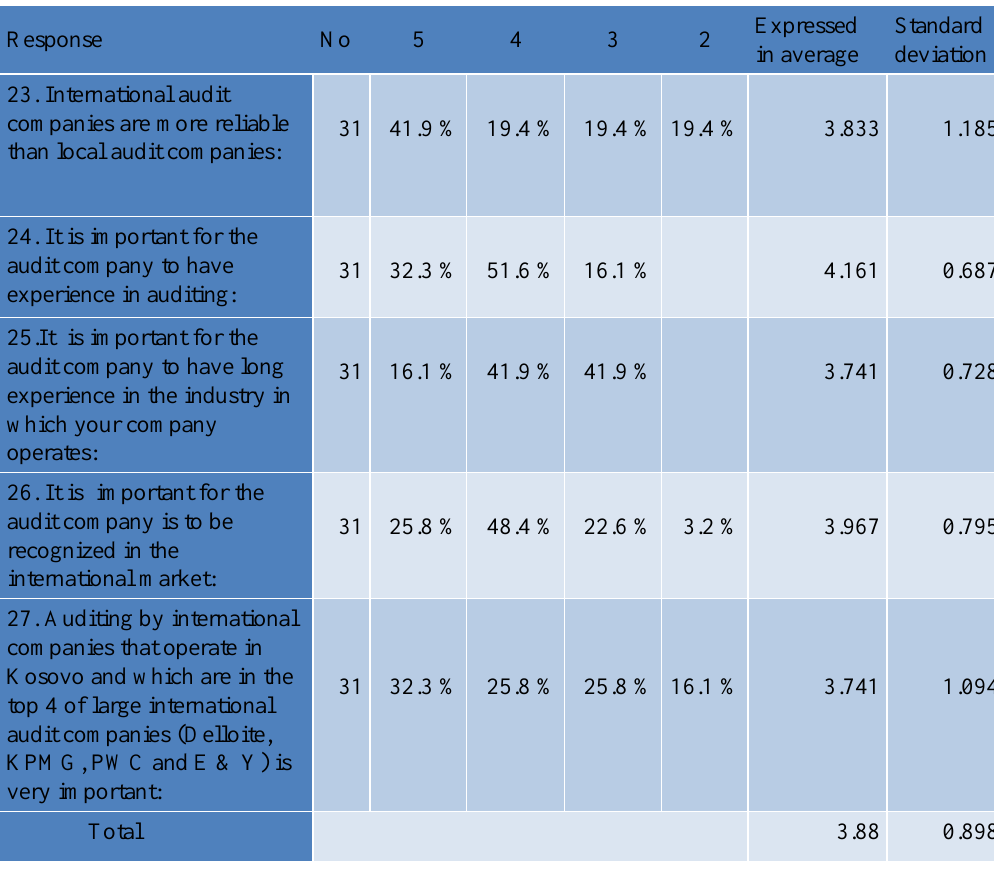
Table 6. Determinants of auditor’s reputation [Table and calculations made by